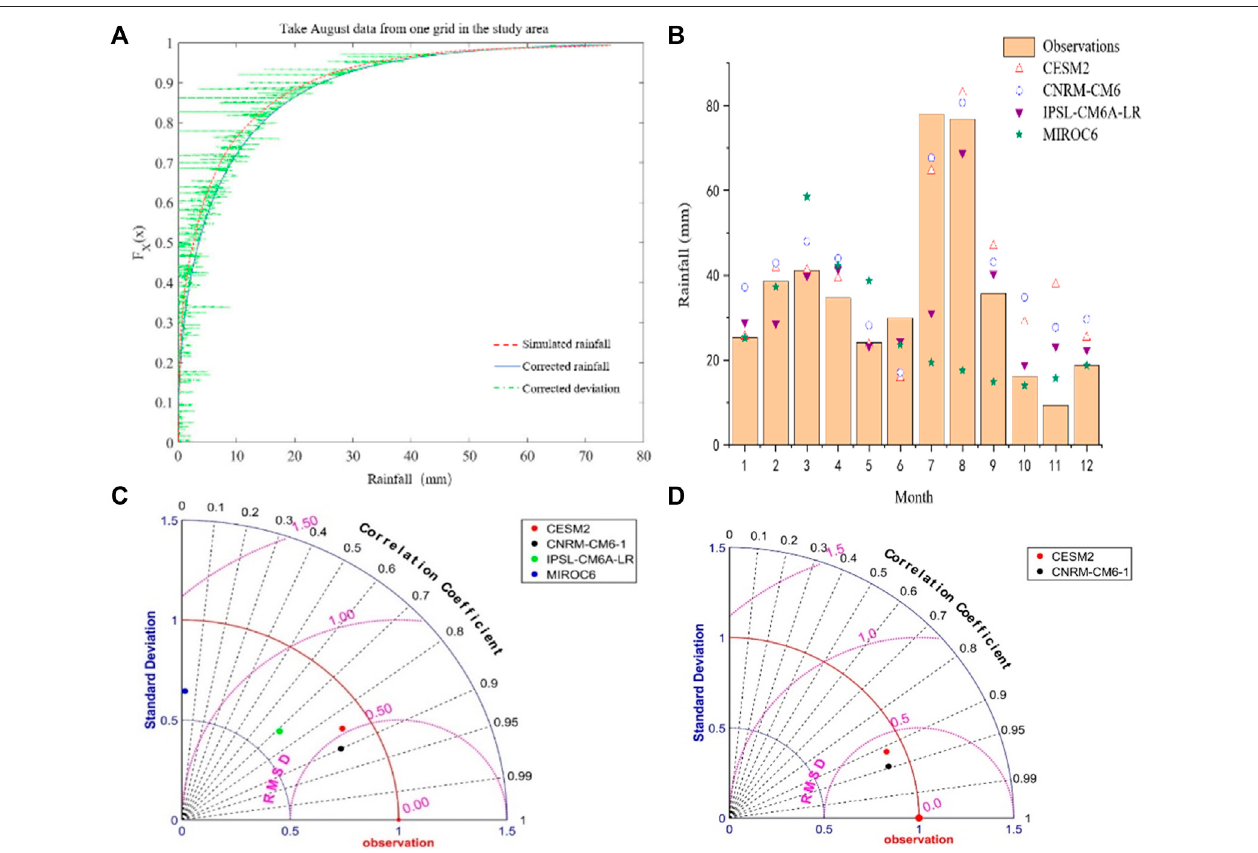
FIGURE 3 | (A) Model correction process (Taking August data of a grid point as an example). (B) Monthly precipitation in the base period and the monthly precipitation simulated by the model data. (C) Taylor diagram of four model data. (D) Taylor diagram of the model after deviation correction.